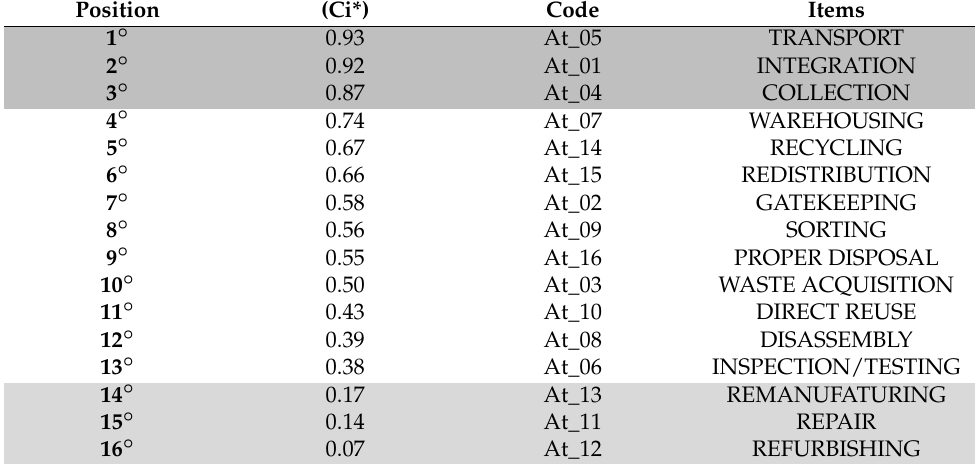
Table 10. Ranking of the